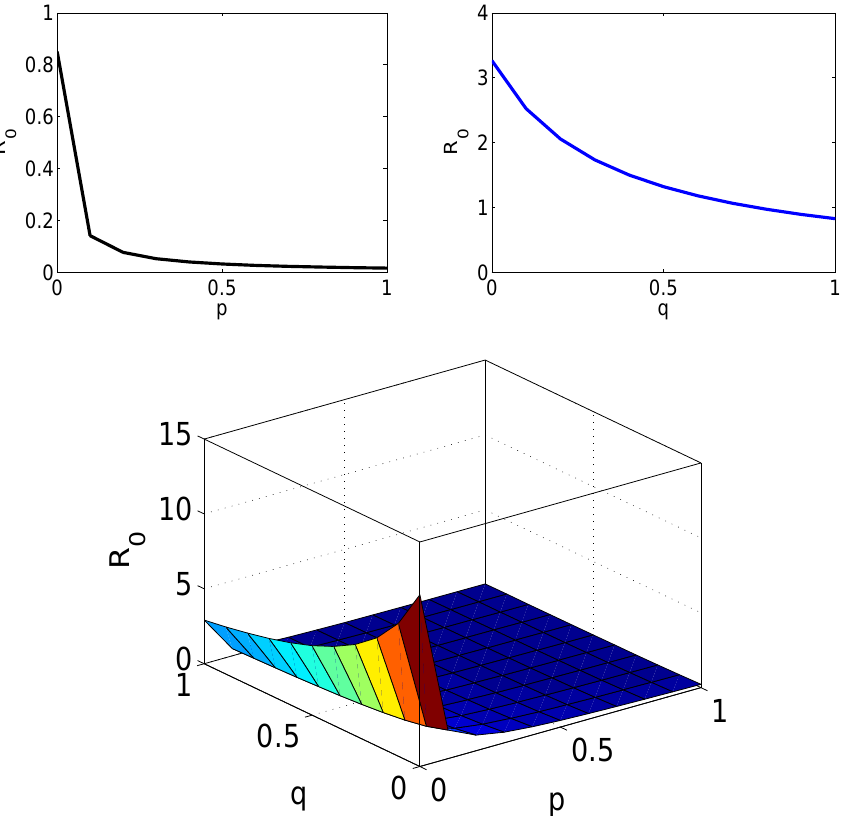
Figure 6. Variational curves and variational curved surface of R 0 with p and q